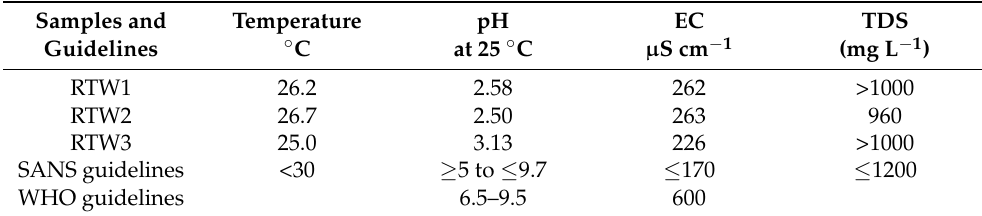
Table 1. Average levels of physical parameters in pond and tailing effluents.